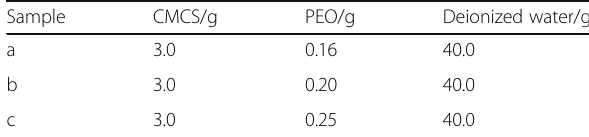
Table 1 Solution components for electrospinning Sample